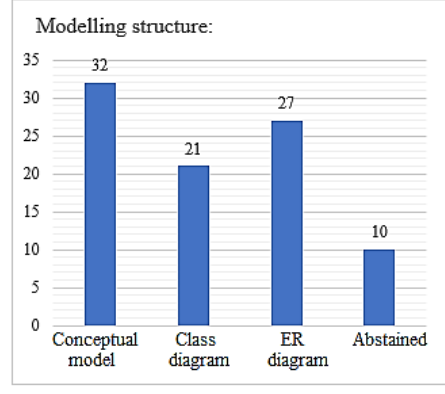
Fig. 5. Modelling system structure.